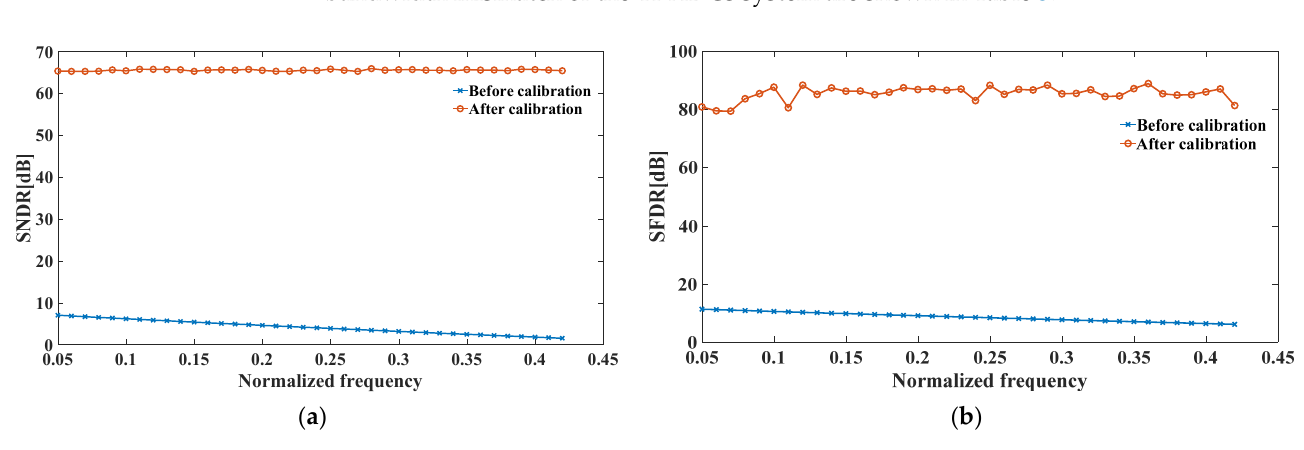
Figure 7. Performances of the proposed method. ( a ) The SNDR of TI ‐ ADCs with different frequen ‐ cies; ( b ) the SFDR of TI ‐ ADC with different frequencies.